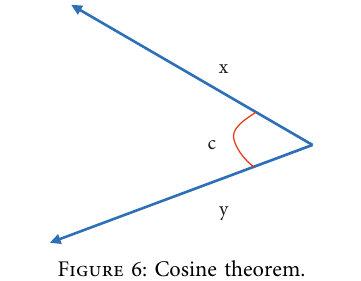
Figure 6: Cosine theorem.